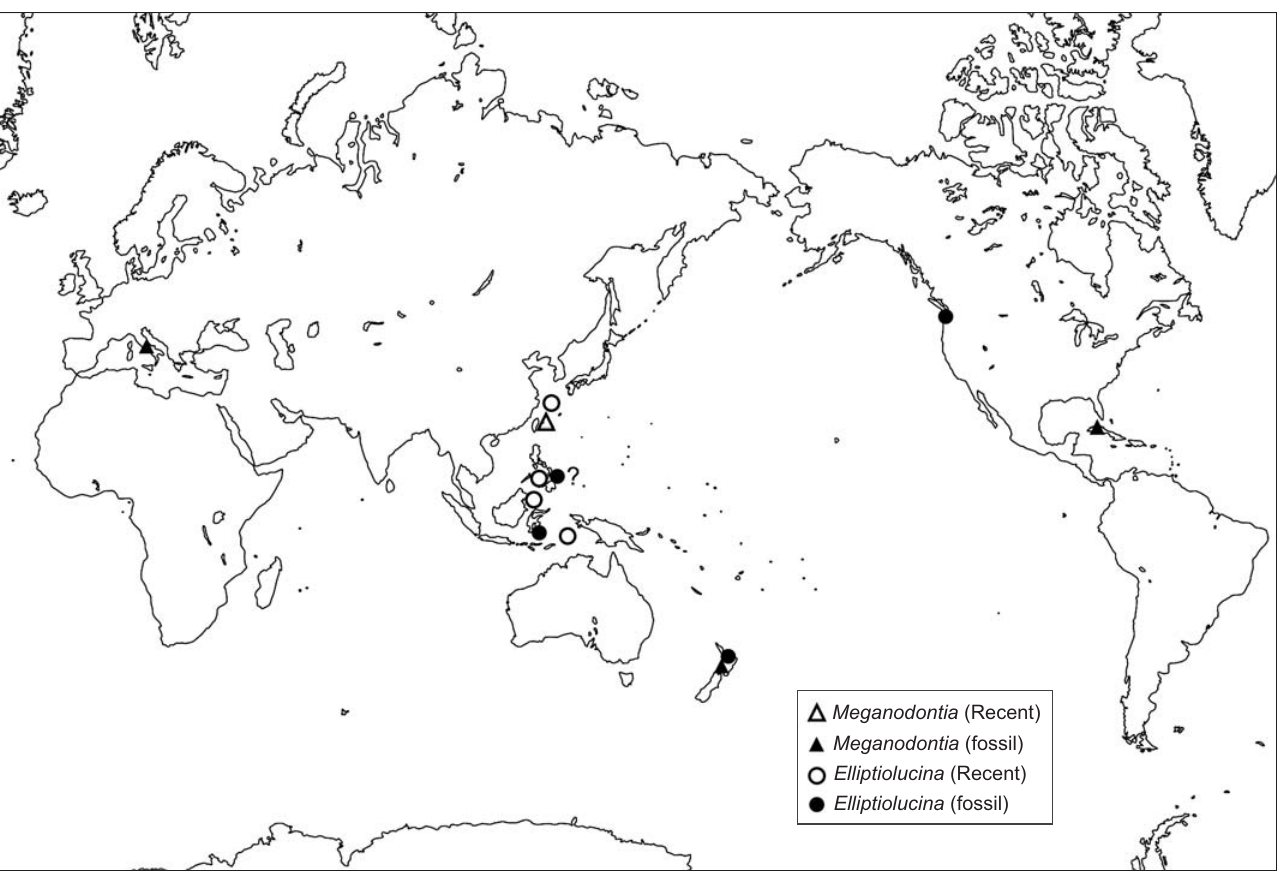
Fig. 6. Distribution of the ancient and Recent Meganodontia and Elliptiolucina . The Recent data are from Bouchet and Cosel (2004), Cosel and Bouchet (2008), and Glover and Taylor (2016). The fossil data are based on Kase et al. (2007), Kiel (2013), Kiel and Hansen (2015), Kiel and Taviani (2017), and this